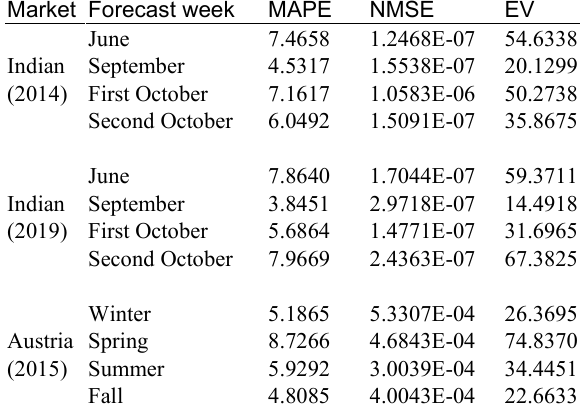
Table 1. The best number of neurons in the input, hidden, and output layers obtained with the NN-LM model for both the markets